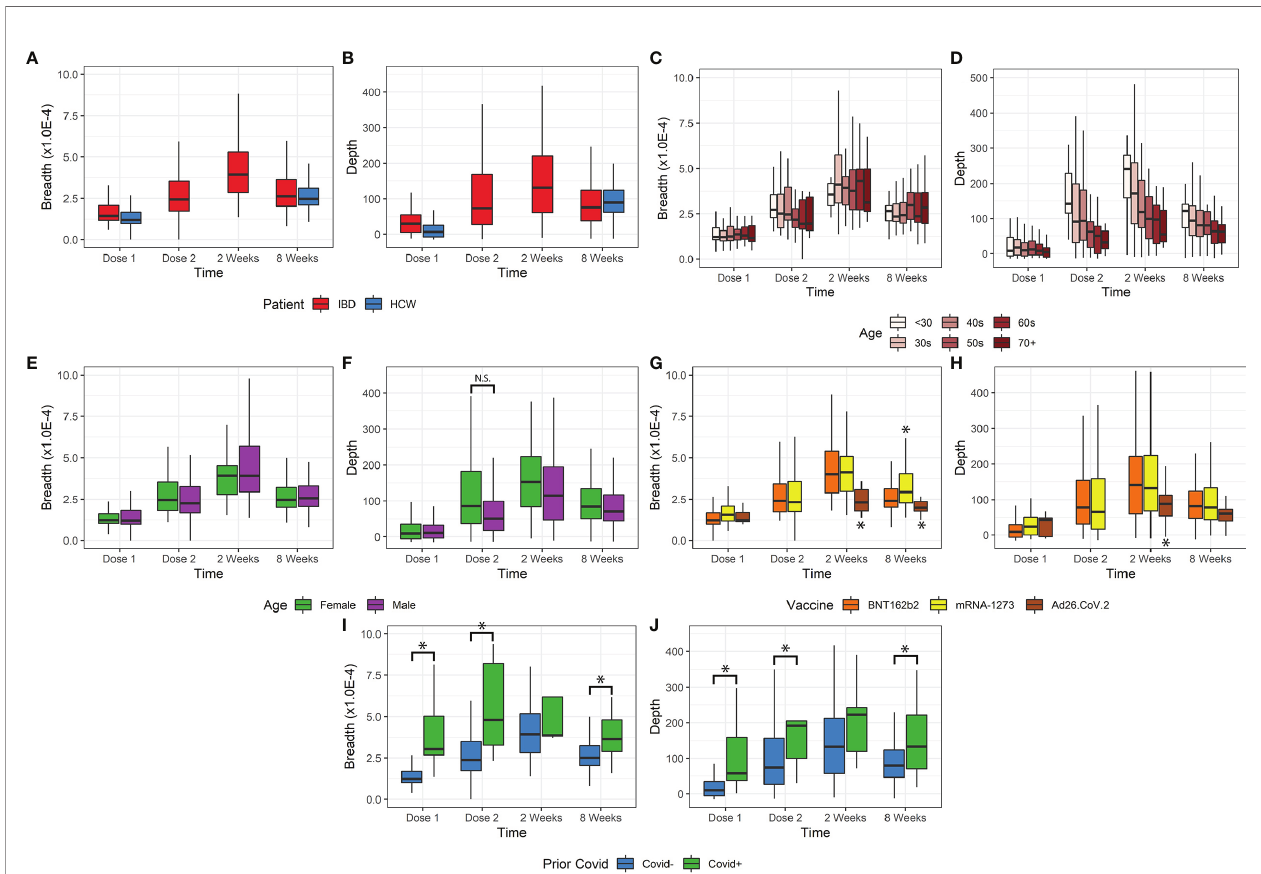
FIGURE 1 | Breadth and depth metrics after COVID-19 vaccination. (A, B) Breadth and depth increases over time, peaking at 2 weeks after vaccine dose 2 in IBD. This increase was observed for both IBD and HCW cohorts. (C, D) Depth, but not breadth, was dependent on age. Younger patients have greater depth and more clonal expansion, with a similar number of unique clones detected. (E, F) Female patients only exhibited increased depth at dose 2 but were also younger. (G, H) Ad26.COV2.S vaccination resulted in lower depth. mRNA-1273 vaccination resulted in slightly higher breadth only at 8 weeks after dose 2. (I, J) Prior covid infection resulted in higher breadth and depth, except at 2 weeks after vaccination (*p<0.05). N.S., not-signi fi